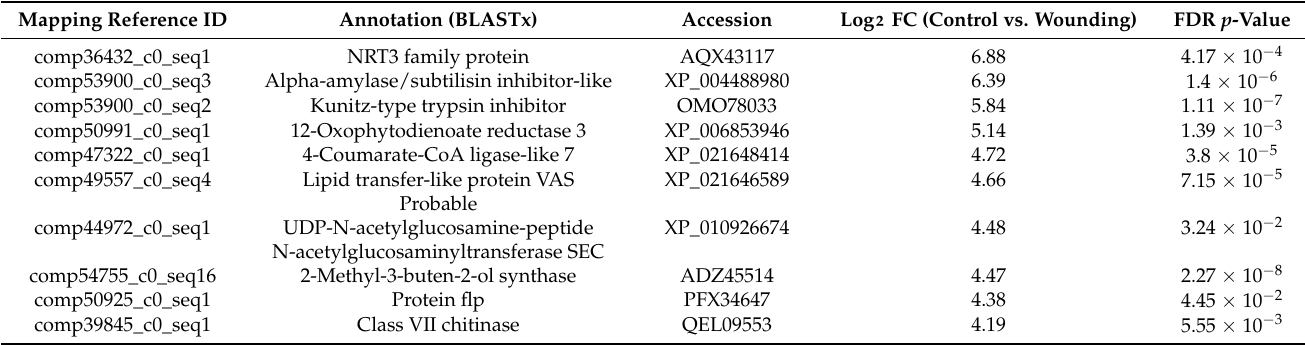
Table 5. Ten most upregulated transcripts after wounding. Table 3. Eleven (10 annotated) most upregulated transcripts after inoculation (compared to